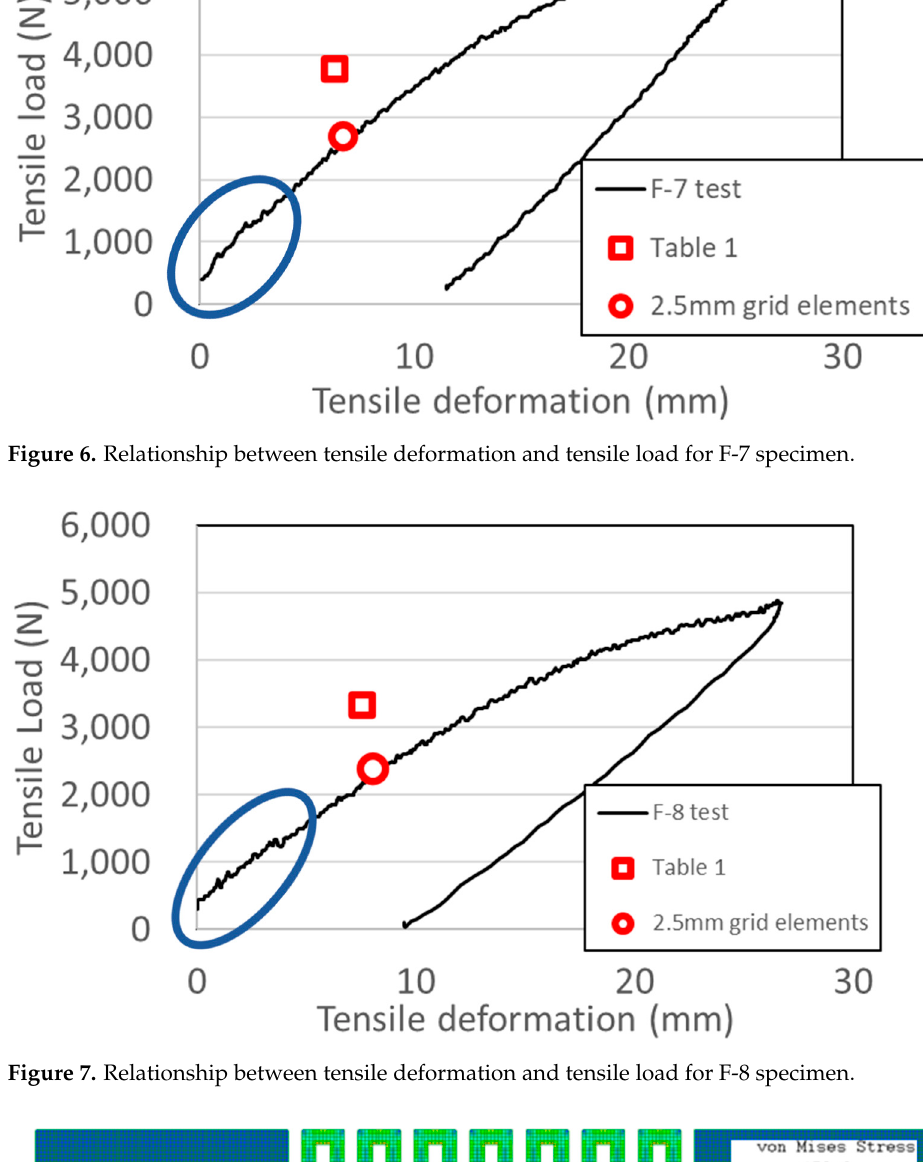
Scheme 1. Tensile experiments by universal testing machine (F-7, at around 4400 N of tensile load). Figure 7. Relationship between tensile deformation and tensile load for F-8 specimen.